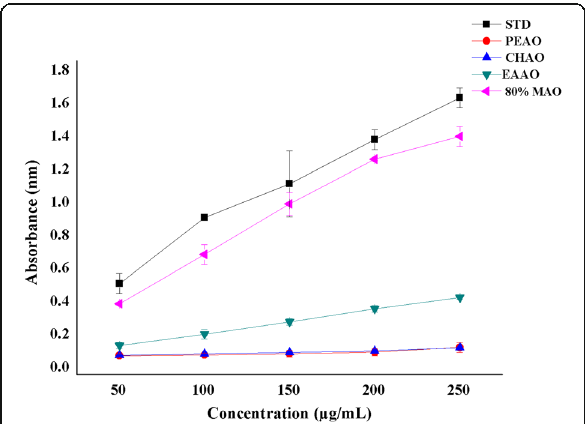
Fig. 2 Reducing power activity of Petroleum ether, Chloroform, Ethyl acetate, and 80 % Methanol Extracts of A. occidentale. * PEAO: Petroleum ether extract of A. occidentale, CHAO: Chloroform extract of A. occidentale, EAAO: Ethyl acetate extract of A. occidentale, 80% MAO: 80% Methanol extract of A. occidentale. * Results are expressed as mean ± SD ( n